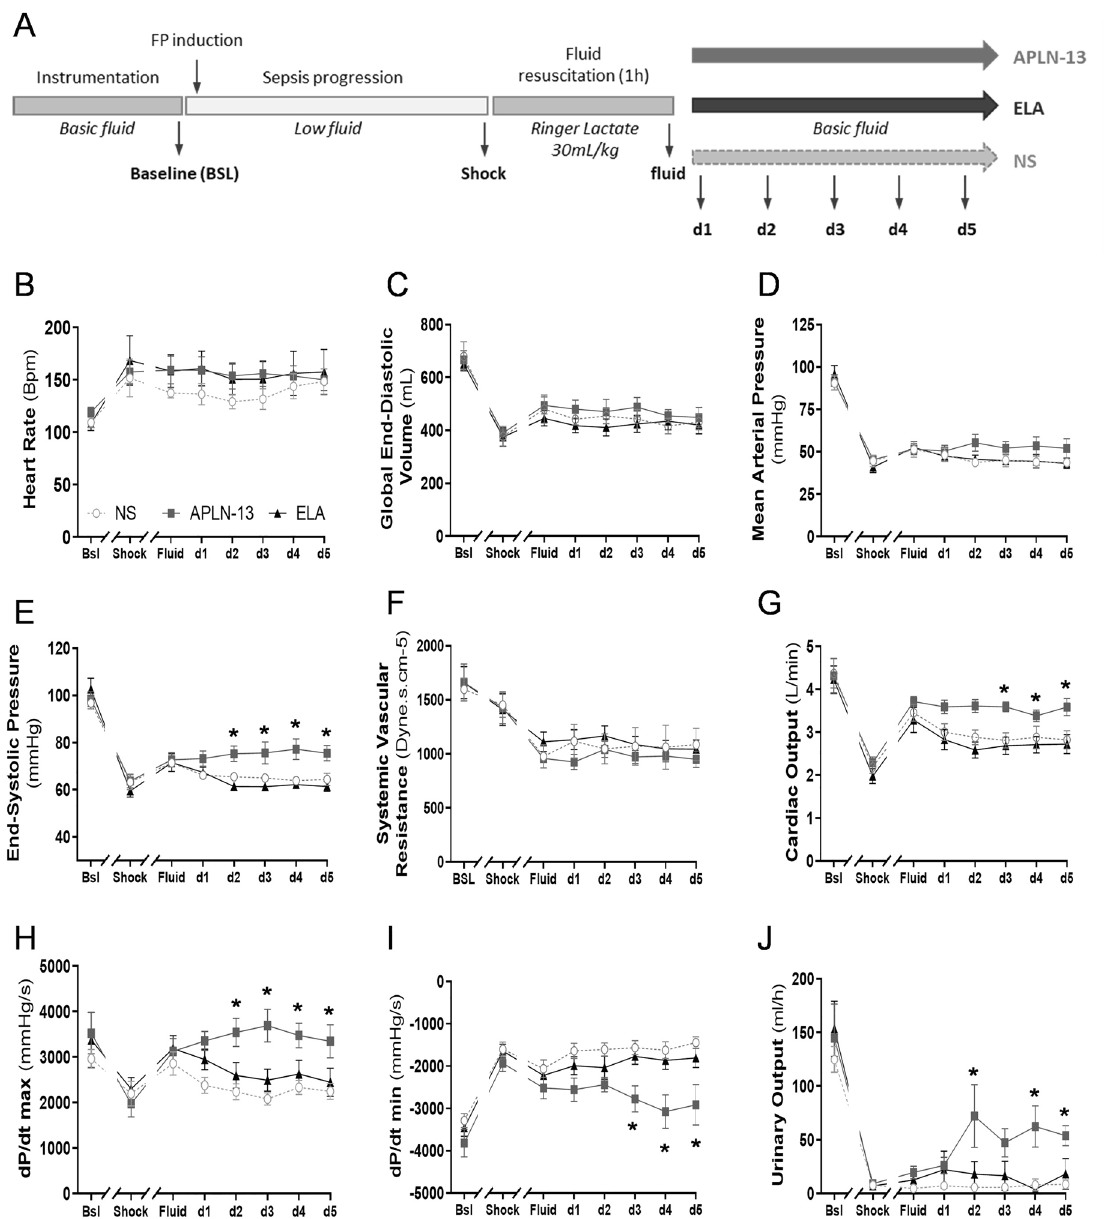
Figure 2. Apelin-13 (APLN-13) improves cardiorenal axis function in an ovine model of fecal peritonitis (FP). ( A ) Study Design: Sheep were first prepared as described in Fig. 1. After baseline assessment, fecal peritonitis was induced by intraperitoneal injection of a stool slurry (2 g/kg) and five criteria of shock must be met before fluid resuscitation challenge (RL 30 mL/kg for 1 h) and start of infusions of 20 min-incremental doses of APLN- 13 or Elabela (ELA) vs. normal saline (NS), as described in Fig. 1. See “Methods” section for details. Septic shock was achieved 251 ± 15 min after FP induction. ( B–I ) Heart rate, global end-diastolic volume, mean arterial pressure; end-systolic pressure; systemic vascular resistance; cardiac output, dP/dt max and dP/dt min were assessed by PiCCO-Volef thermodilution or left ventricular catheterization at the baseline (Bsl), shock (Shock), and fluid resuscitation challenge (Fluid) time points and for d1 to d5 corresponding to increasing apelinergic doses. Following fluid resuscitation, APLN-13 maintained cardiac output and increased end-systolic pressure from 0.25 nmol/kg/h. APLN-13 also enhanced dP/dt max along with decreased dP/dt min from 0.25 nmol/ kg/h and 2.5 nmol/kg/h, respectively. ( J ) Urinary output was measured by percutaneous bladder catheterization. APLN-13 increased urinary output from 0.25 nmol/kg/h. All results are expressed as the mean ± SEM (n = 6/ group). Statistical analyses for quantitative variables were performed with a paired Student’s t -test (normally distributed variables). Dose–response and time-course analyses were performed with repeated measures two- way ANOVA followed by Tukey’s multiple comparison test. *p < 0.05 vs. normal saline (NS)-infused